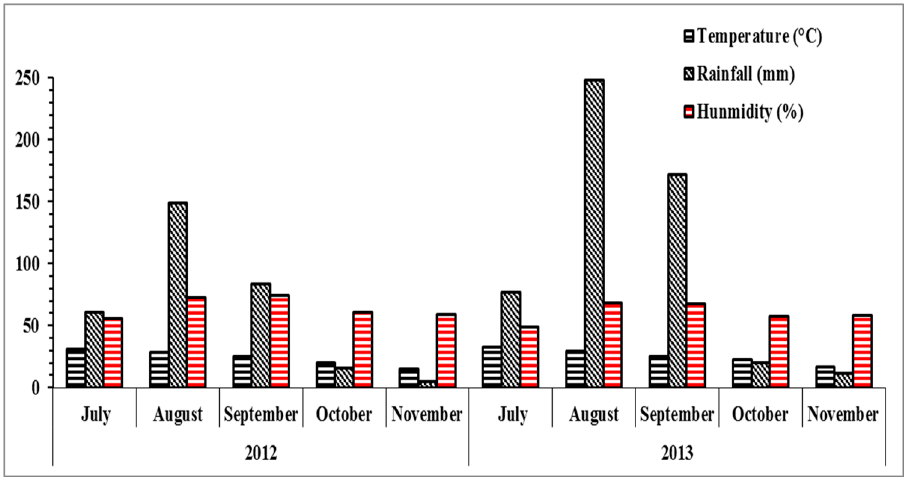
Figure 1. Monthly rainfall, average temperature and humidity from July to November in the crop periods of 2012 and 2013.